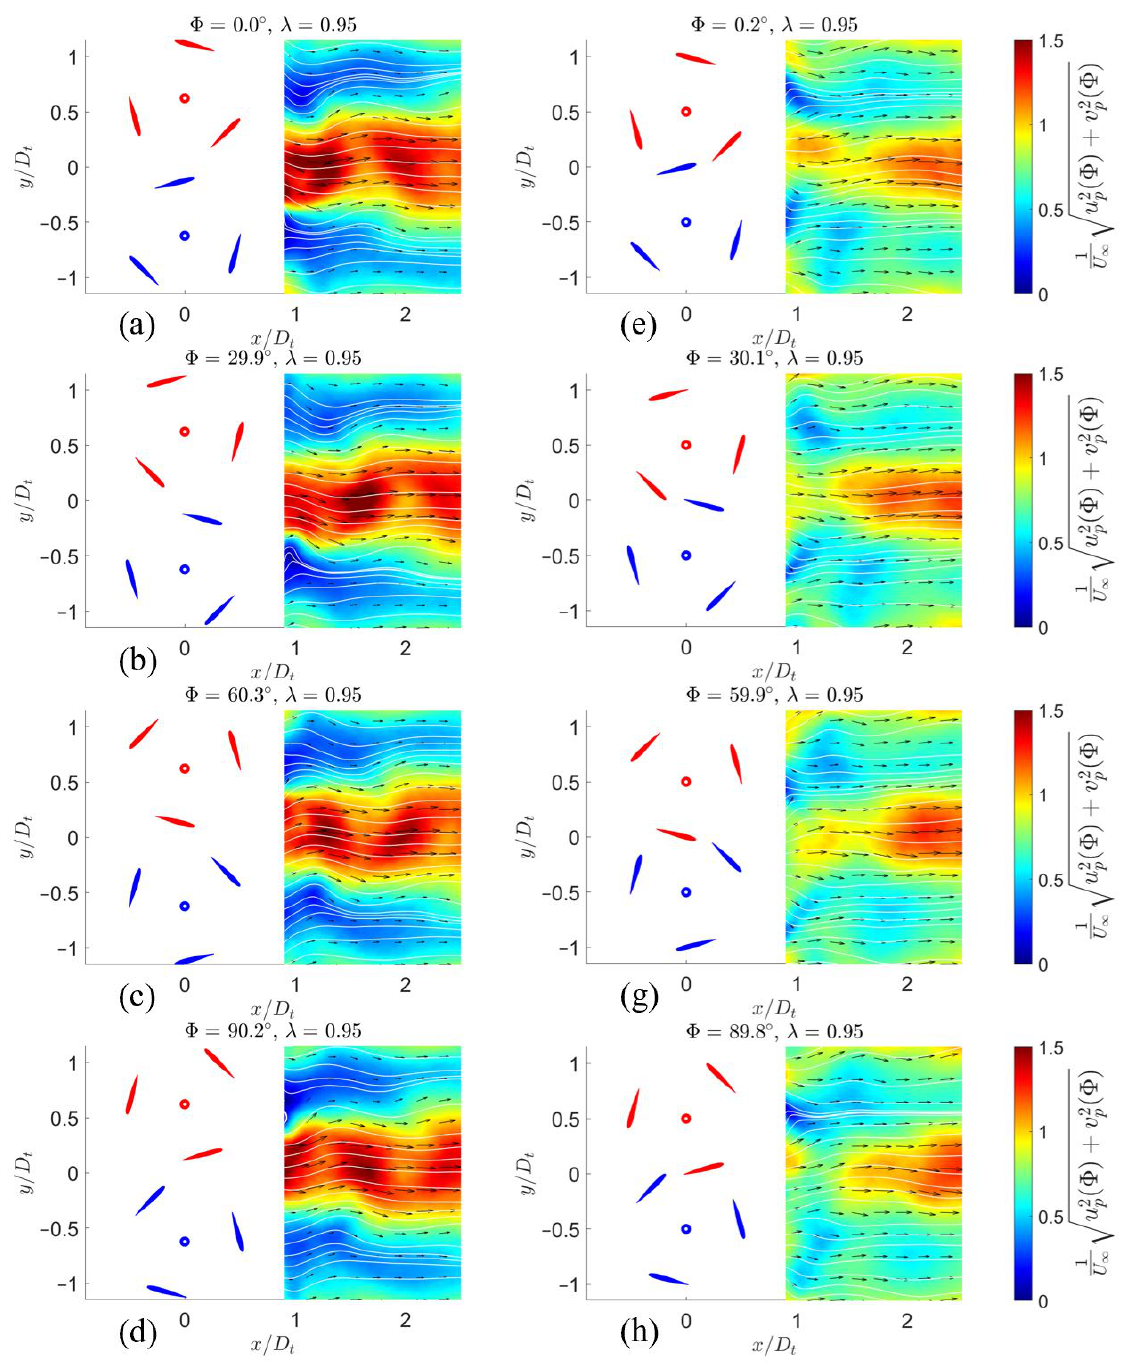
Figure 12. The phase-averaged flow fields behind the forward counter-rotating ( a – d ) and overlapping ( e – h ) configurations at ∆Φ = 60 ◦ and λ = 0.95. The power coefficients of these configurations are 0.120 and 0.128 for forward counter-rotating ( ∆Φ = 60 ◦ ) and overlapping configuration correspondingly. The displayed phase angles Φ belong to turbine T1 in red color. The color shows the non-dimensionalized phase-averaged velocity